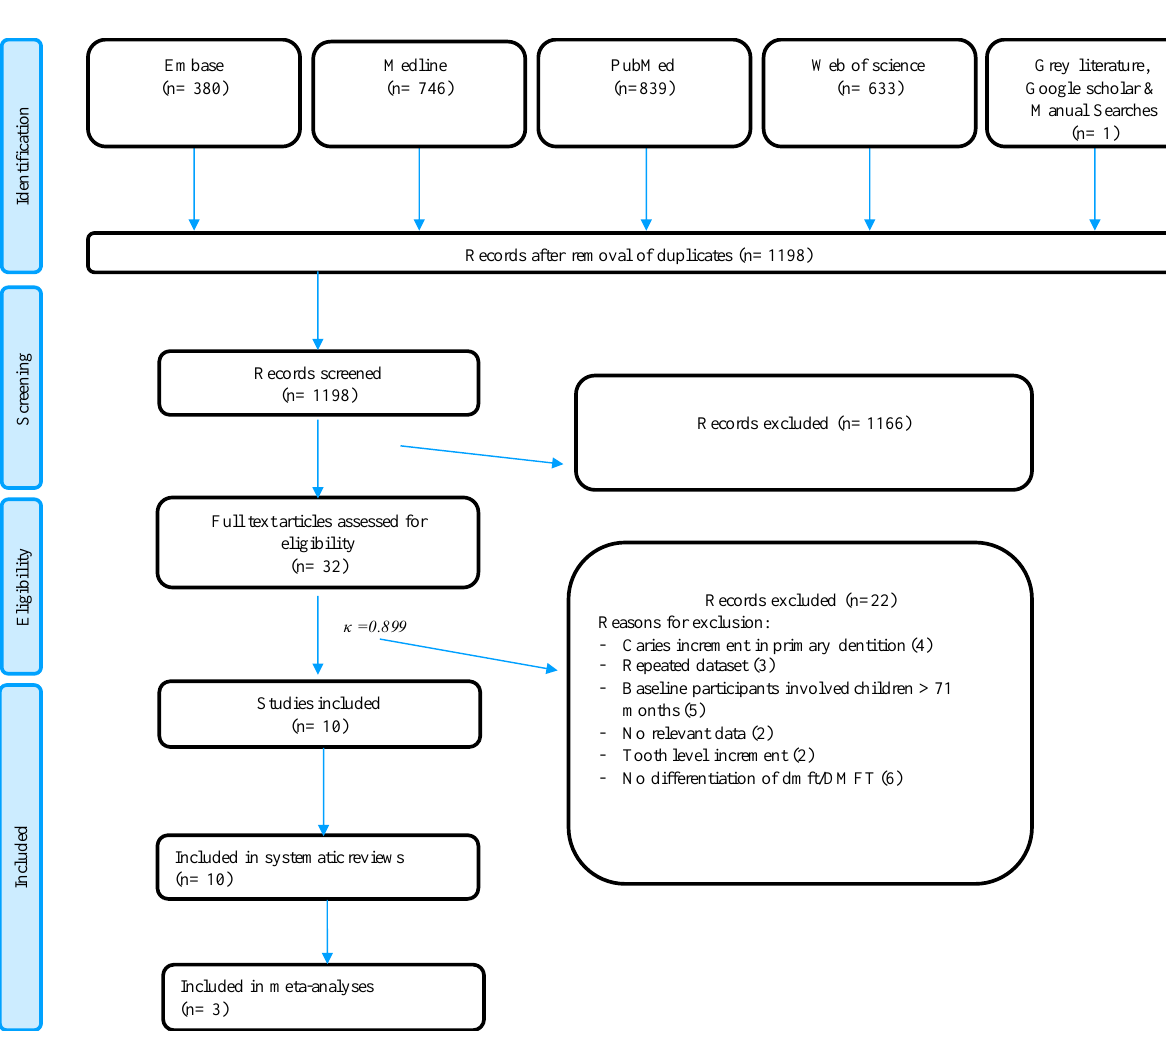
Figure 1 details the screening process in accordance with the PRISMA guidelines. A